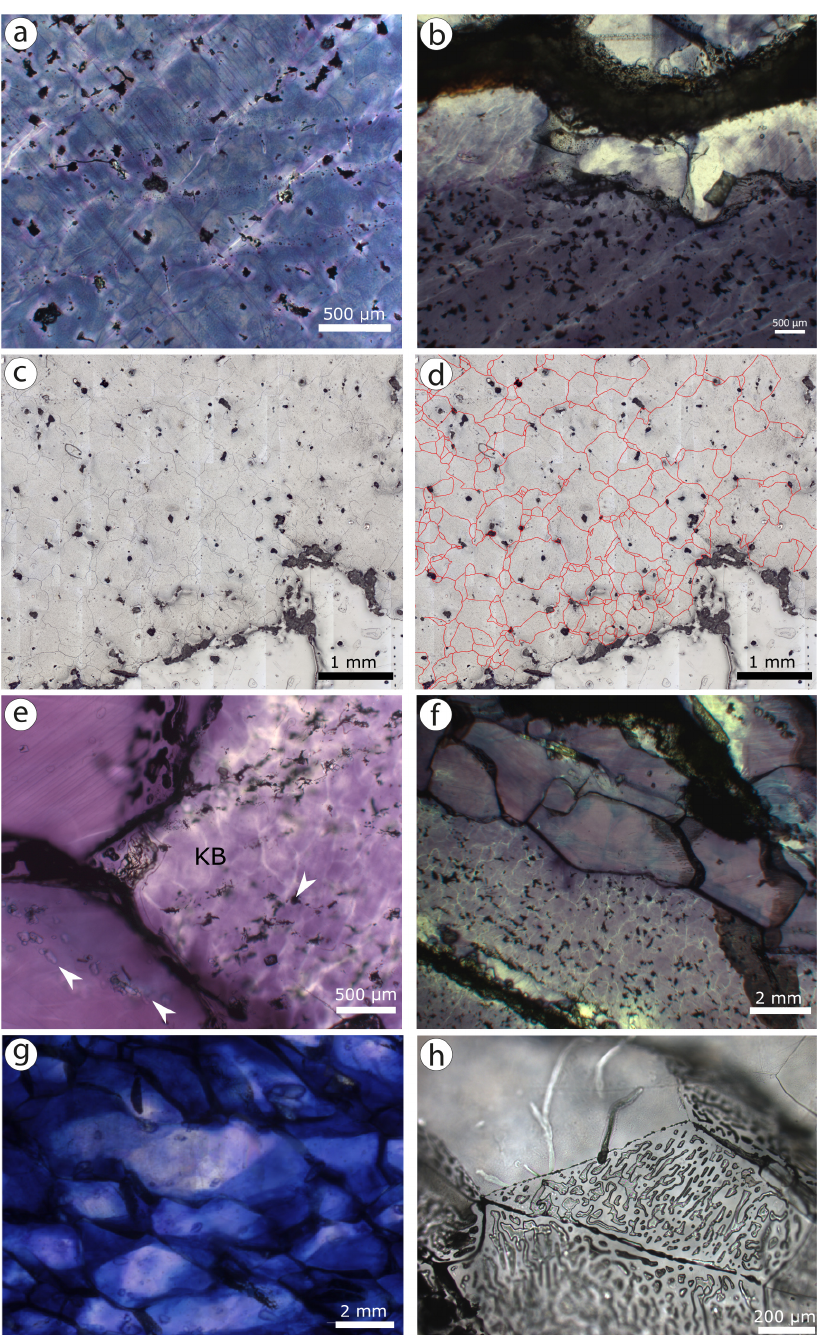
Figure 5. (a) Transmitted-light micrograph of gamma-irradiated KS-08 (Winschoten) sample showing abundant dark inclusions in Kristall- brocken, slip bands, and white gamma-decorated subgrain boundaries. (b) Transmitted-light micrograph of gamma-irradiated KS-05 (Win- schoten) sample showing abundant dark inclusions, slip bands, and white gamma-decorated subgrain boundaries in Kristallbrocken next to anhydrite band and inclusion-poor light halite in between. (c) Reflected-light image of sample KS-08 (Winschoten) Kristallbrocken with abundant subgrains and mineral inclusions used for piezometry. Exact location indicated in Fig. 3 (KS-08, s2). (d) Digitized subgrain bound- aries are an example of the data used for piezometry. (e) Transmitted-light micrograph of gamma-irradiated sample KS-13B (Zuidwending) showing Kristallbrocken (KB) grain with gamma-decorated subgrains and abundant primary dark solid inclusions (white arrow). Clear halite grain shows array of reworked elongated clear anhydrite minerals parallel to grain boundary (white arrow) as well as abundant fluid inclusions at grain boundaries. (f) Transmitted-light micrograph of gamma-irradiated Zuidwending sample KS-02 showing subgrain structures, abun- dant dark inclusions, and clear elongated halite grains next to it. (g) Transmitted-light micrograph of gamma-decorated halite grains showing light cores and directional overgrowth of elongated fine-grained halite in sample BS-B (Pieterburen). (h) Transmitted-light micrograph of thick section showing abundant fluid inclusions at fine-grained halite grain boundary of Pieterburen sample (Sadler, 2012). https://doi.org/10.5194/se-14-271-2023 Solid Earth, 14, 271–291,